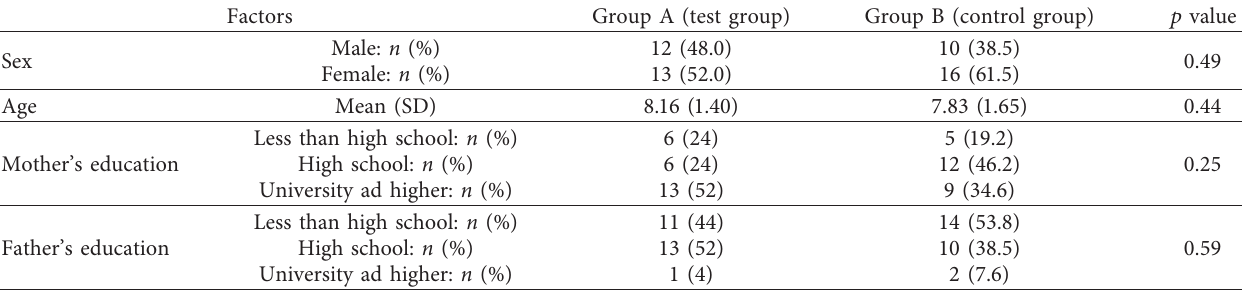
Table 1: Sample description.